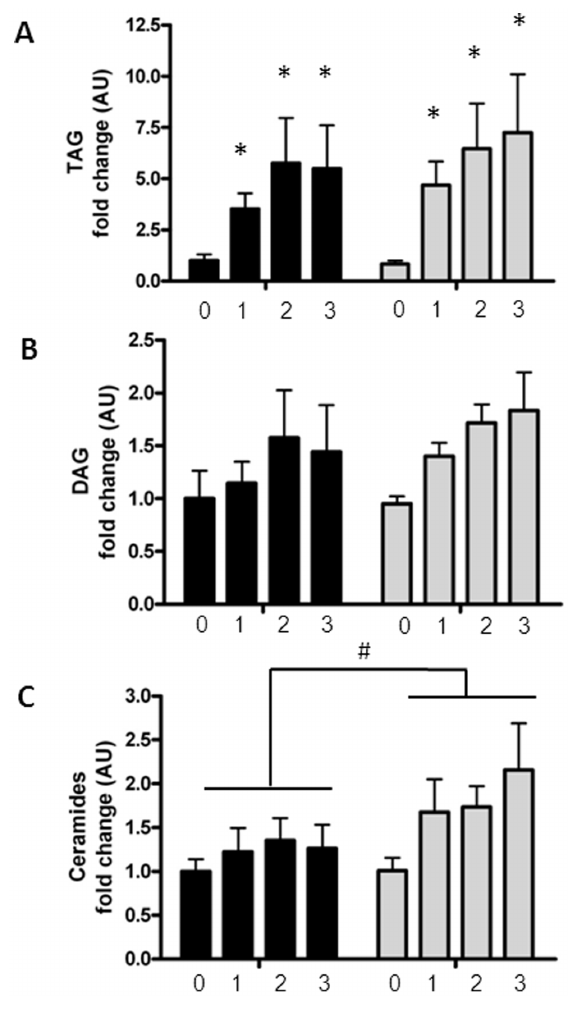
Figure 1. Lipid metabolite content in palmitate treated myotubes from premenopausal and postmenopausal women. Satellite cells were isolated from vastus lateralis biopsies from premenopausal and postmenopausal women. Cells were grown in culture until mature myotubes were formed. Myotubes were treated with palmitate (300 m M) in the last one, two or three days of differentiation. Triacylglycerol (TAG), diacylglycerol (DAG) and ceramide content were determined in the myotube cell lysates by liquid chromatography. Content of lipid metabolites in pre-myotubes (n=6, black bars) and post-myotubes (n=5, white bars) in response to palmitate treatment, (A) Intramyocellular TAG levels increased in response to palmitate treatment in both pre- and post-myotubes, (B) Intramyocellular DAG levels were unaffected by both palmitate treatment and menopausal status, (C) Intramyocellular ceramide levels were higher in post-myotubes compared to pre-myotubes. Significant effect of palmitate treatment; * p , 0.05. Significantly different from premenopausal; # p , 0.05. 0: Zero days of palmitate treatment (control), 1: One day of palmitate treatment, 2: Two days of palmitate treatment, 3: Three days of palmitate treatment. All data were normalized to the premenopausal control group. Data are presented as means 6 SEM.